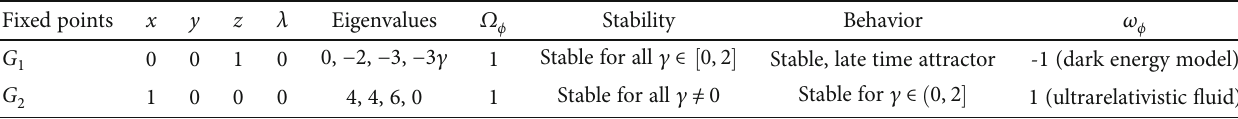
Table 4: Table for dynamical system with inverse power law potential